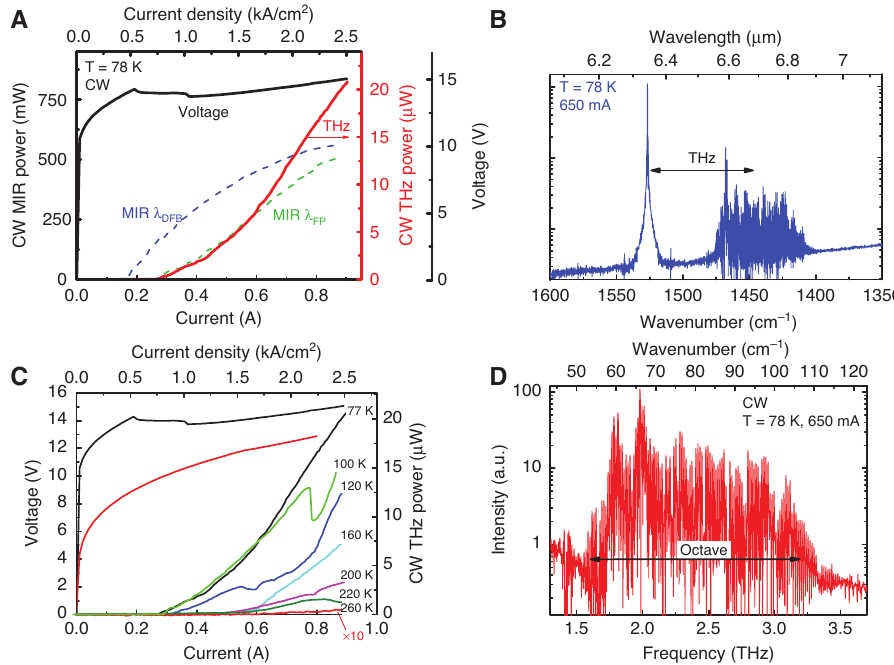
Figure 14: CW performance of a 3-mm-long, 12- μ m-wide DFB/FP device for broadband THz emission. (A) CW current-light characteristics of the mid-IR pump powers (dashed lines) and the THz emission (solid line). (B) Mid-IR spectrum measured with bias current of 650 mA at the heat sink temperature of 78 K. (C) THz output power measured at different heat sink temperatures. I-V curves measured at 78 and 260 K are also shown. (D) THz spectrum measured with bias current of 650 mA at the heat sink temperature of 78